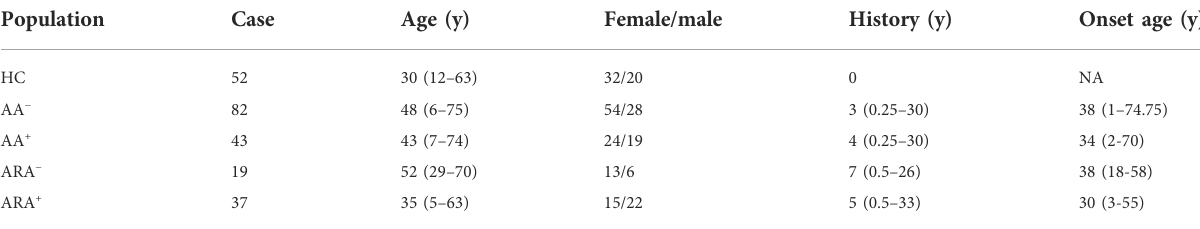
TABLE 1 General characteristics of patients and HC.